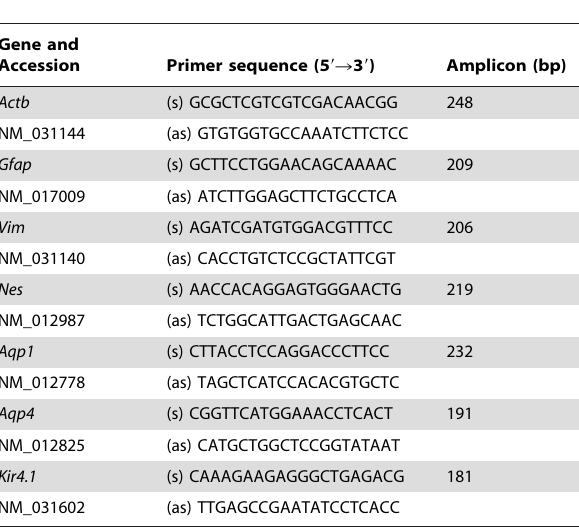
Table 1. Primer pairs used for PCR